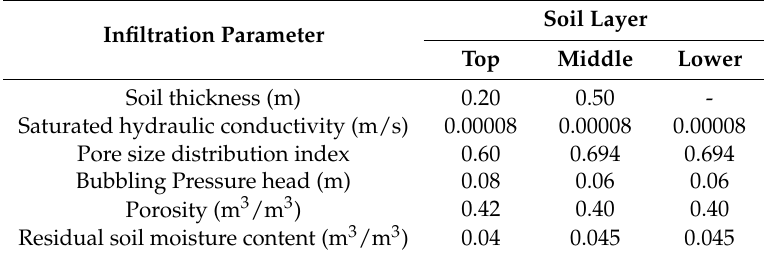
Table 4. Soil parameter values for the Richards infiltration scheme.